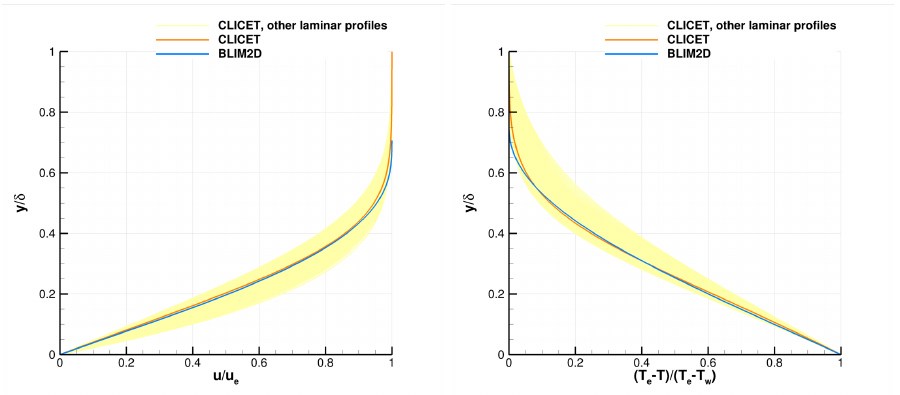
Figure 9. Velocity and temperature profiles produced by CLICET and BLIM2D in the Test Case RUN87b of Table 1, s / c = 0.087. ( Left ): velocity. ( Right ):